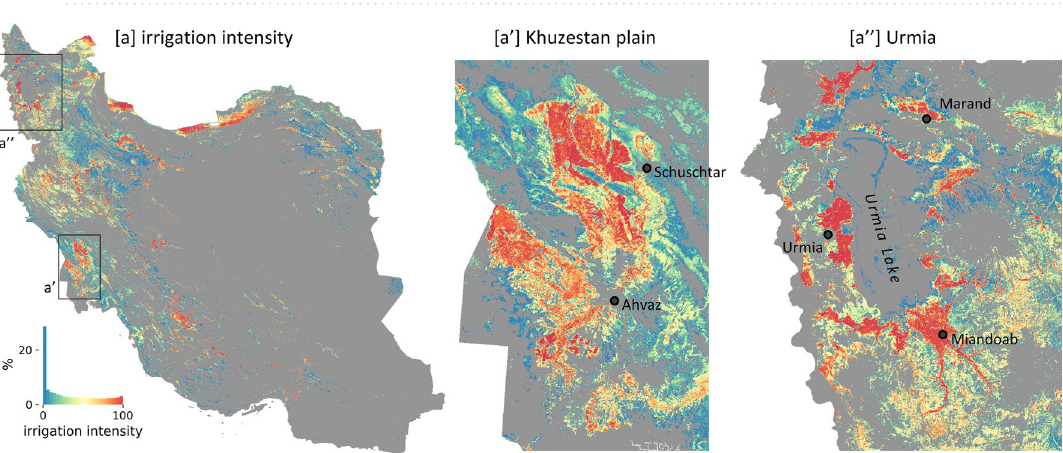
Figure 9. Irrigation intensity as used in Figures 10 and 11. Average of annual irrigation intensities (IrrIntAnn4Q) of the years 2001 and 2003, used to characterize irrigation intensity of agricultural areas already existing at the beginning of the time period of MODIS-based vegetation analysis. ( a ): Map of Iran. Zoom ins: ( a’ ): Khuzestan plain ( a” ): Area around Urmia Lake. Note: Derivation of the irrigation intensity is described